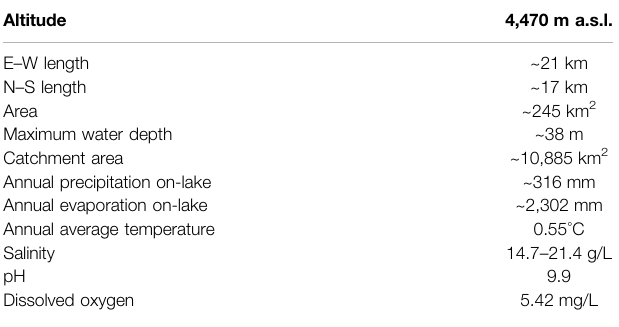
TABLE 1 | General geographical, climatological, and limnological data for Dagze Co. Altitude